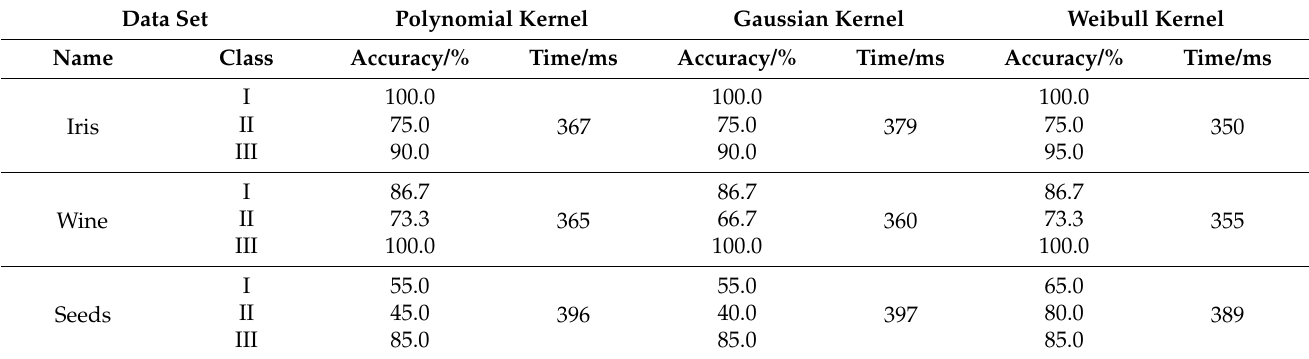
Table 1. Performance comparison of SVDD algorithms based on different kernel